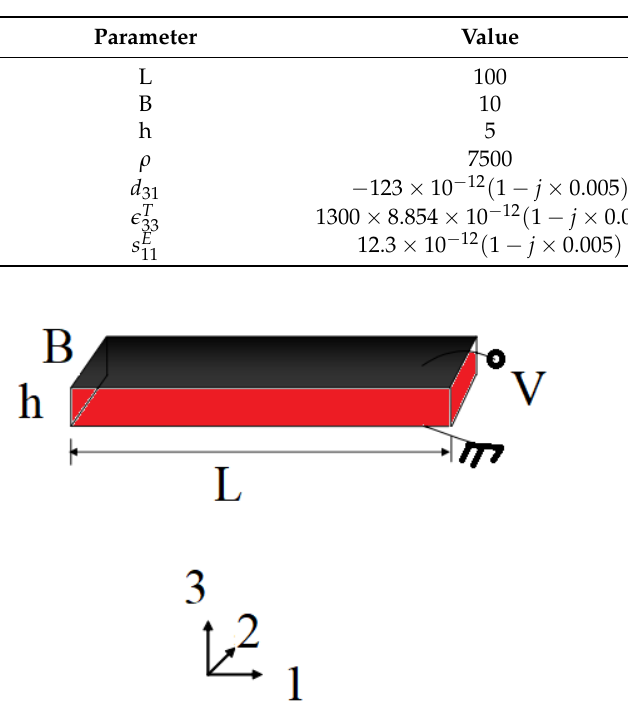
Table 8. Material and geometrical parameters for the case of heat generation.